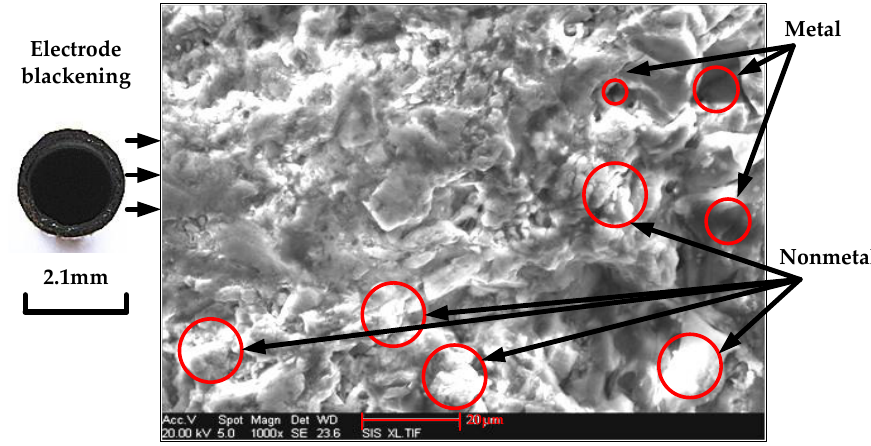
Figure 6. Micro morphology of tool electrode end face after short-circuiting.